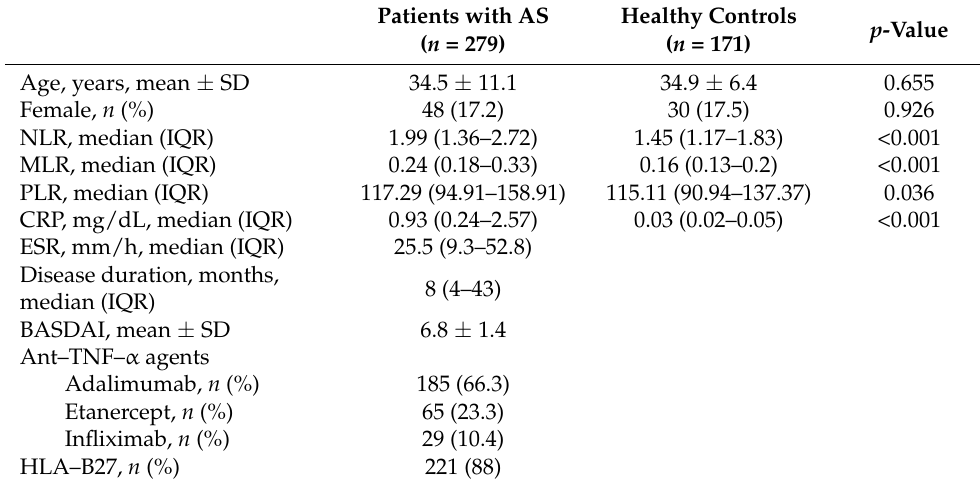
Table 1. Baseline clinical characteristics in patients with ankylosing spondylitis and healthy controls. Patients with AS ( n =